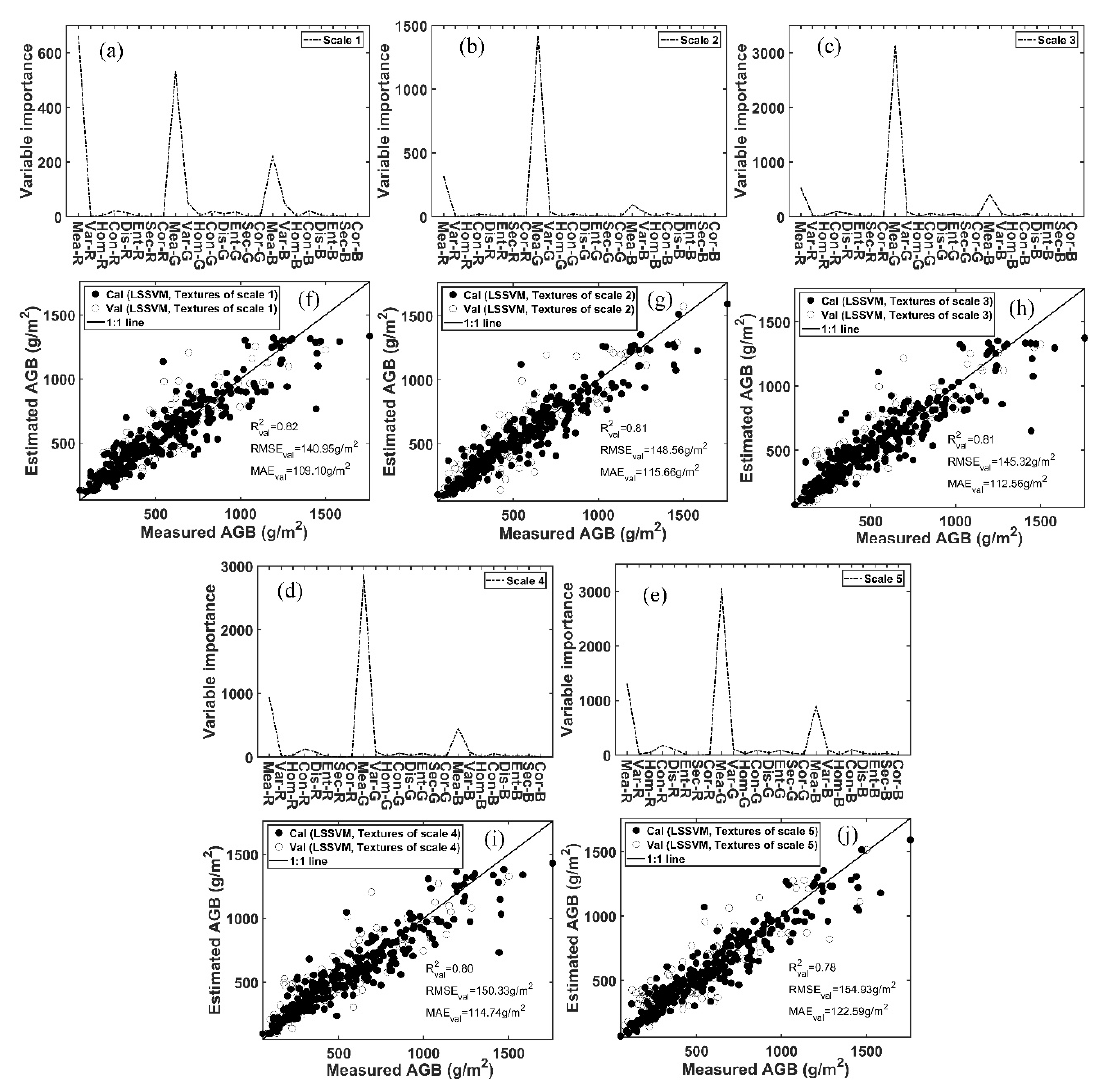
Figure 8. Importance values ( a – e ) and predictive performance ( f – j ) of the textures at each scale based on LSSVM regession analyses.